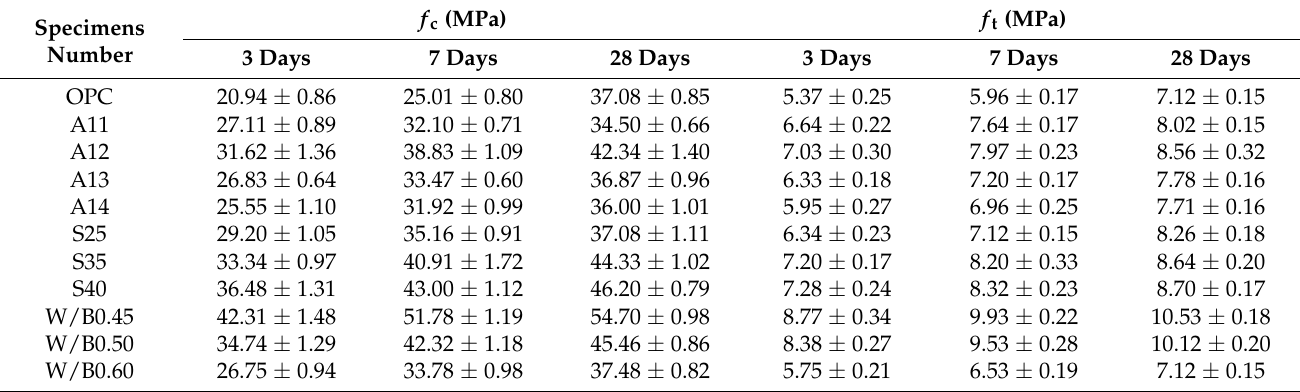
Table 3. Test results for each type of